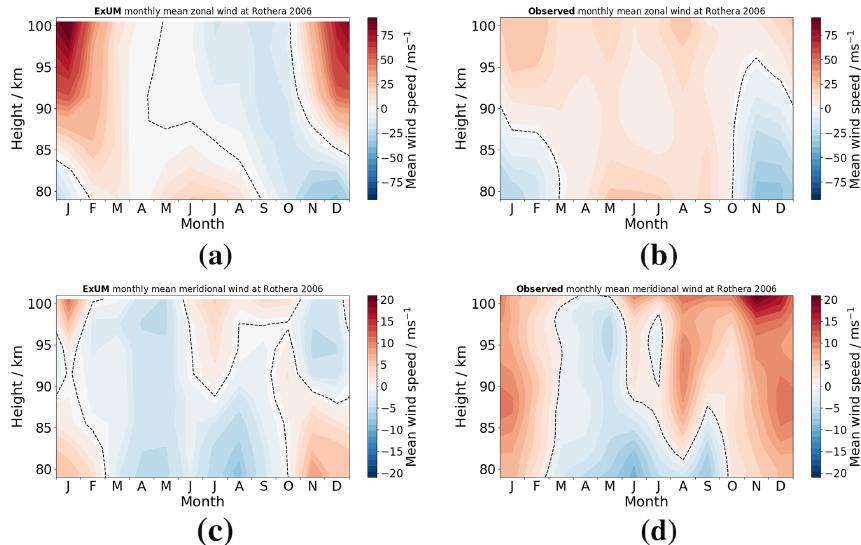
Figure 7. Time–height monthly-mean wind contours at Rothera in 2006 comparing (a) ExUM zonal wind with (b) observed zonal wind and (c) ExUM meridional wind with (d) observed meridional wind. The dashed black line represents the zero-wind line. Colour bars are kept consistent left to right for